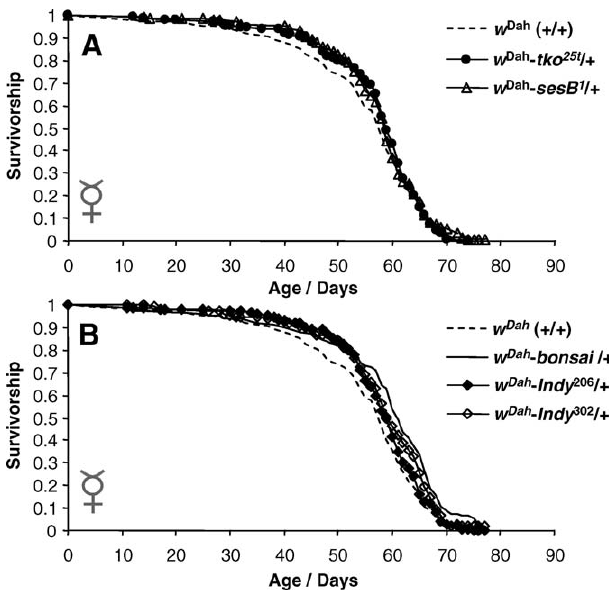
Figure 1. Effects on Longevity of tko 25t and Indy Are Abolished by Backcrossing A) Virgin females backcrossed six times to w Dah . Median lifespans are 59, 59, and 58 d for sesB 1 / þ , tko 25t / þ , and w Dah ( þ / þ ) females, respectively. Log-Rank test v 2 and p -values: sesB 1 / þ versus þ / þ ( v 2 ¼ 5.59, p ¼ 0.0181), tko 25t / þ versus þ / þ ( v 2 ¼ 1.47, p ¼ 0.2258), and sesB 1 / þ versus tko 25t / þ ( v 2 ¼ 0.84, p ¼ 0.3583). B) Virgin females backcrossed six times to w Dah . Median lifespans are 60, 60, 62, and 58 d for Indy 206 / þ , Indy 302 / þ , bonsai 1 / þ , and w Dah ( þ / þ ) females, respectively. Log-Rank test v 2 and p -values: Indy 206 / þ versus þ / þ ( v 2 ¼ 5.14, p ¼ 0.0234), Indy 302 / þ versus þ / þ ( v 2 ¼ 9.50, p ¼ 0.0021), and bonsai 1 / þ versus þ / þ ( v 2 ¼ 31.86, p ,